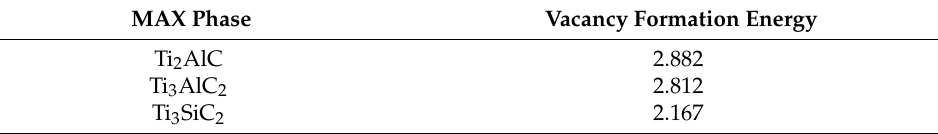
Table 2. Vacancy formation energy in eV of an A-group atom in bulk MAX